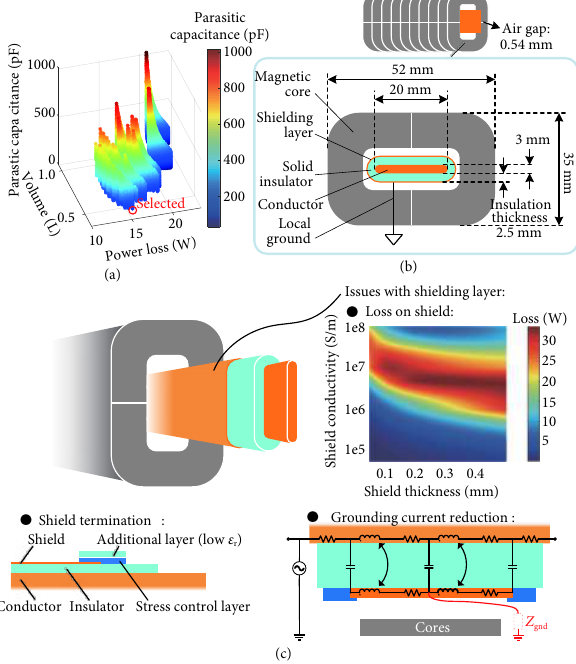
Fig. 7 (a) Multi-objective optimization and (b) the selected inductor struc- ture. (c) Shield overview and its related issues addressed in ref.